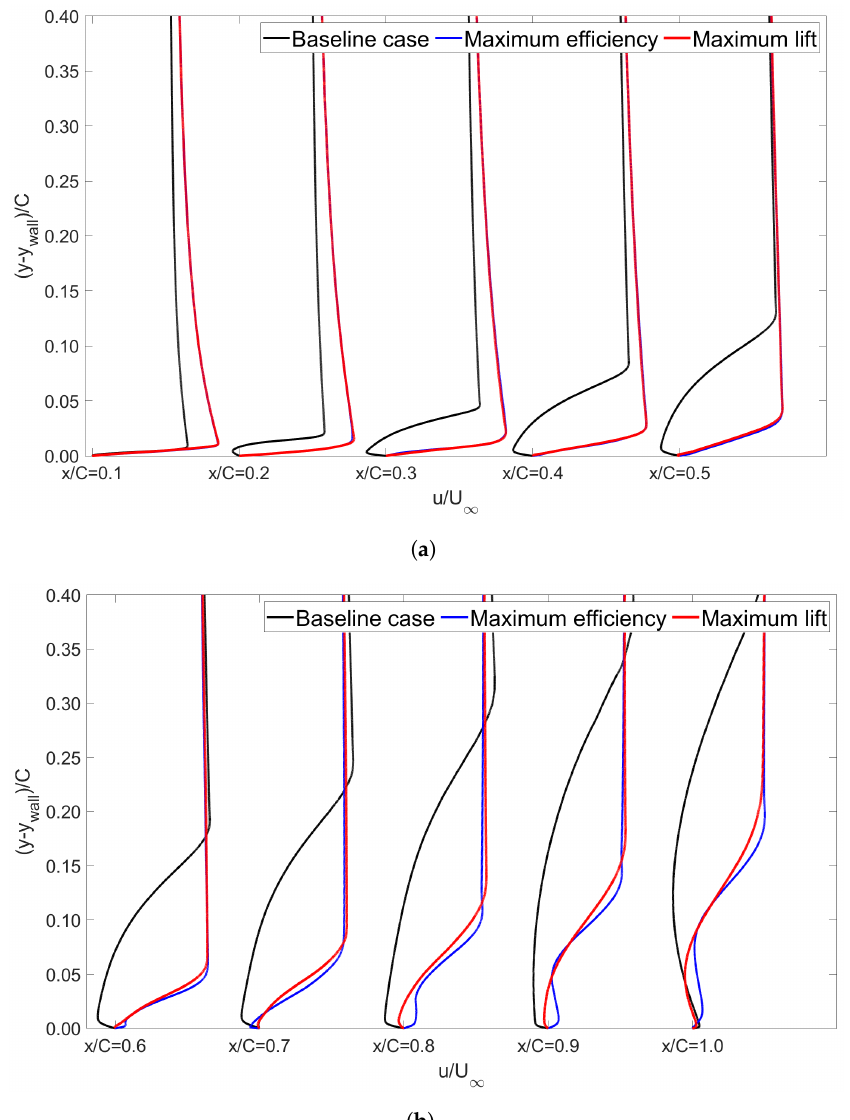
Figure 12. Mean velocity profiles for the baseline, maximum E and maximum L cases, from x / C = 0.1 to x / C = 1. ( a ) Velocity profiles of the mean velocity from x / C = 0.1 to x / C = 0.5. ( b ) Velocity profiles of the mean velocity from x / C = 0.6 to x / C =